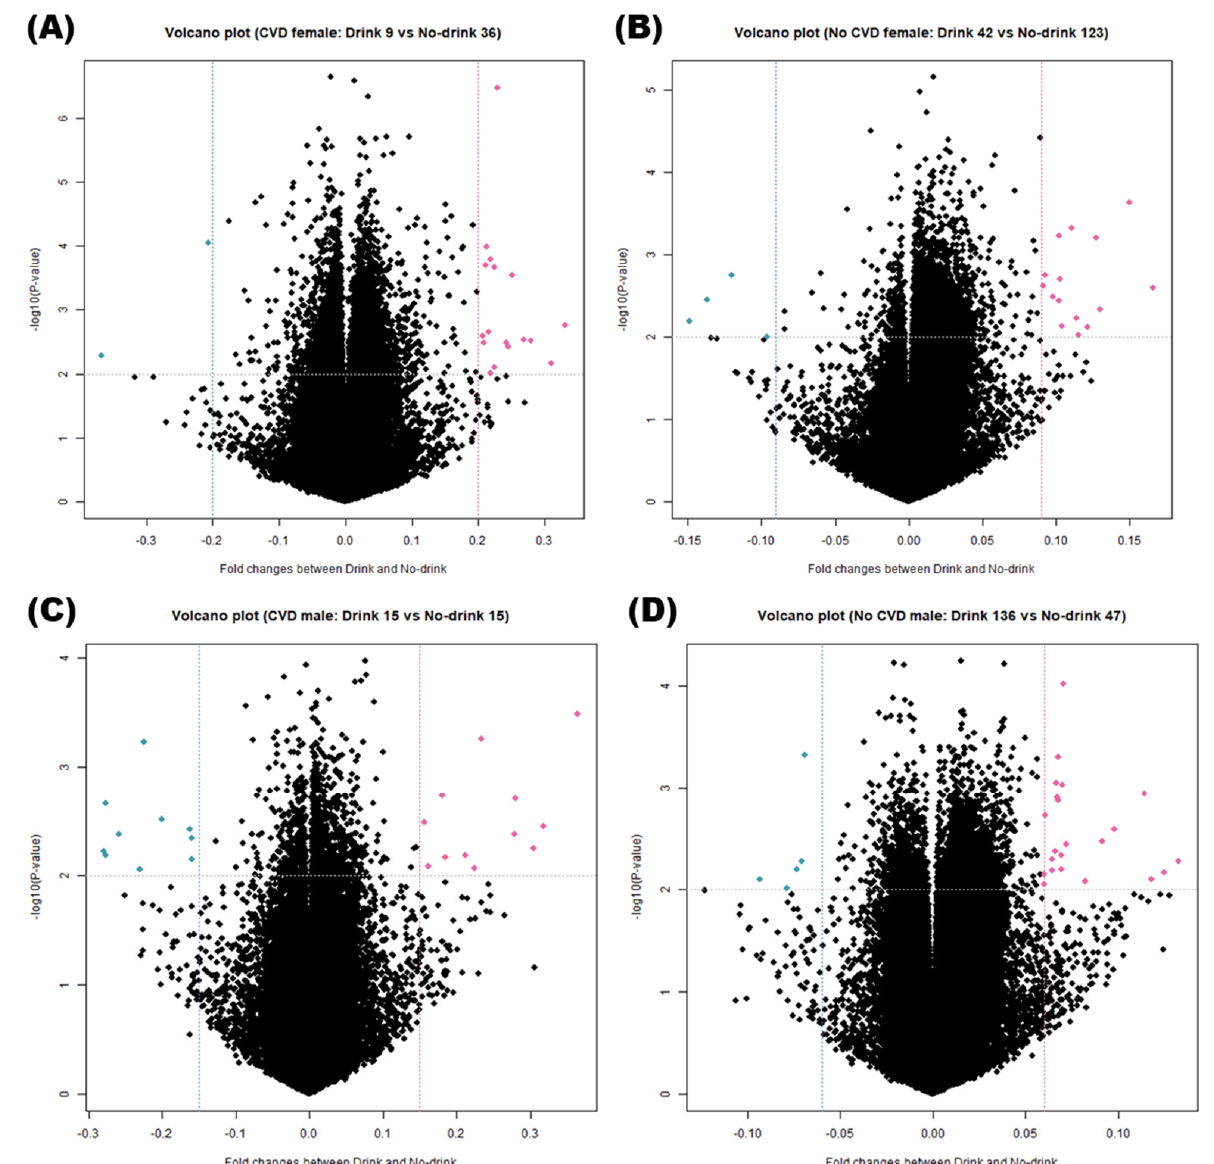
Figure 3. Volcano plot of differentially methylated regions (DMRs) indicating difference between four pairs of four groups. Total 423 subjects were divided into four groups based on the cardiovascular diseases (CVDs) (at least one of myocardial infarction, coronary artery, hyperlipidemia, and hypertension) or non-CVDs, and sex (male or female). ( A ) In females with CVD, t -test was performed on nine drinkers versus 36 non-drinkers, and 19 DMRs were found to satisfy the criteria |fold change| > 0.2 and p -value < 0.01. ( B ) In males with CVD, t -test was performed on 15 drinkers versus 15 non-drinkers, and 22 DMRs were found to satisfy the criteria |fold change| > 0.15 and p -value < 0.01. ( C ) In females with non-CVD, 42 drinkers versus 123 non-drinkers and 19 DMRs satisfied the criteria |fold change| > 0.09 and p -value < 0.01. ( D ) In females with CVD, the pairs of 136 drinkers versus 47 non-drinkers were subjected to t -test, and 27 DMRs satisfied the criteria |fold change| > 0.06 and p -value < 0.01. In the volcano plot, higher methylated regions between drinkers and non-drinkers of four groups are indicated as pink dots.